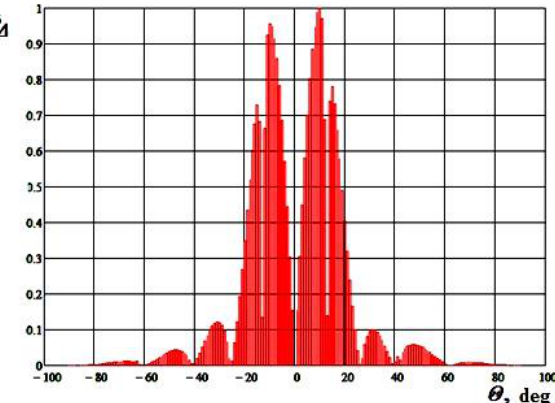
Fig. 6. The differential radiation pattern of the experimental DAA.